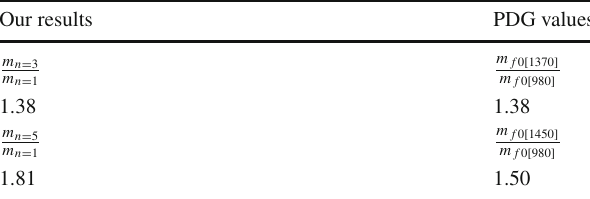
Table 8 The lightest scalar meson mass